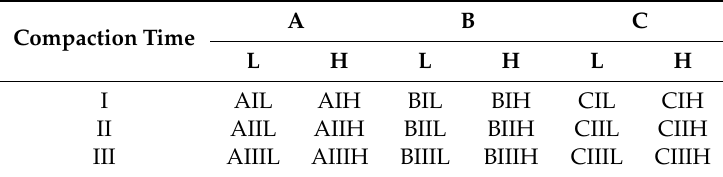
Table 3. Coding used for mixed complete factorial experimental